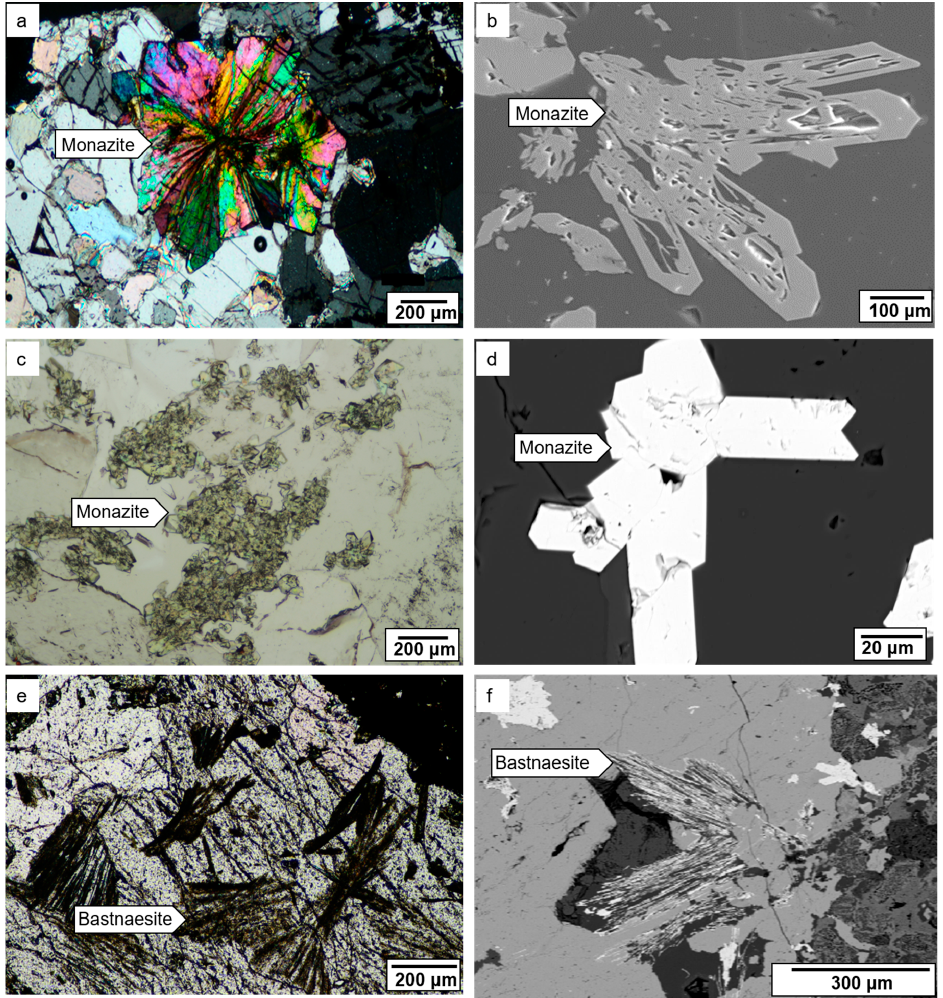
Figure 7. ( a ) Photomicrograph (cross-polarized light) showing a remnant dolomite crystal that was replaced by iron oxides and large monazite crystals. ( b ) Backscatter electron (BSE) image showing textural zoning in large monazite crystals. Note the porous cores of the crystals. ( c ) Photomicrograph (plane-polarized light) of small monazite crystal aggregates. ( d ) BSE image of non-porous monazite crystals from a light carbonatite. ( e ) Photomicrograph (plane-polarized light) of radiating, needle-like bastnaesite. ( f ) BSE image of bastnaesite needles.